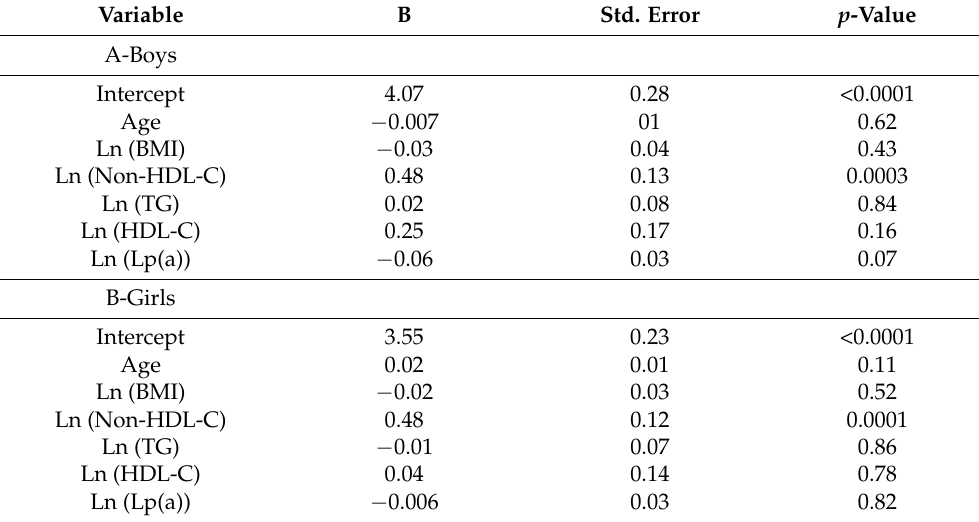
Table 4. Two separate multiple linear regression analyses for boys and girls with PCSK9 as a dependent variable and age, BMI, non-HDL-C, TG, HDL-C, and Lp(a) as independent variables. Due to their non-normal data, lipid parameters, and BMI were entered into the model using their natural logarithmic transform. BMI: Body Mass Index. Variable B Std.